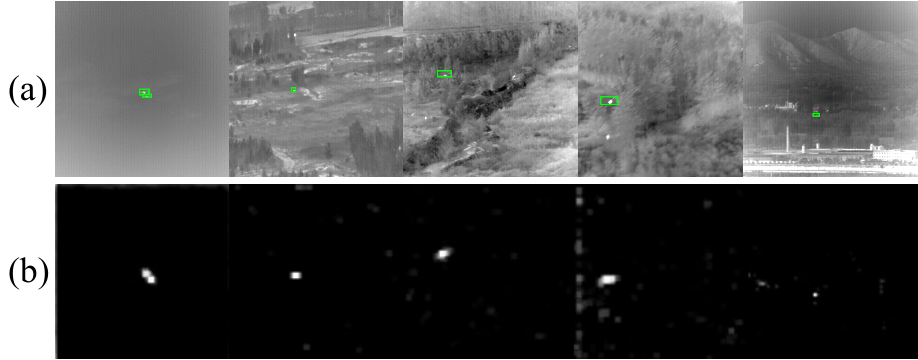
Figure 9. ( a ) Detection results and ( b ) corresponding guide maps. The guide maps highlight the object